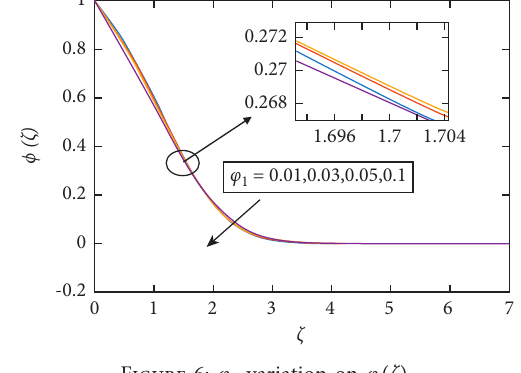
Figure 6: φ variation on φ ( ζ ) . 1